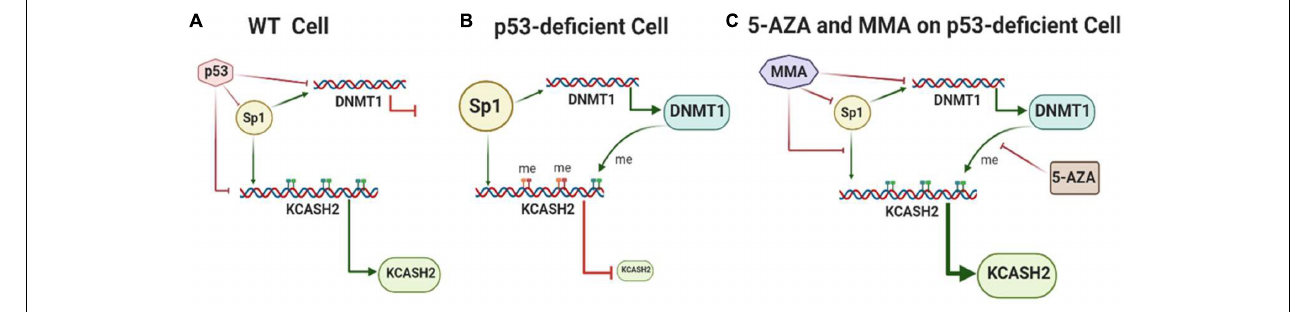
FIGURE 8 | Model of KCASH2 regulation in WT and p53-deficient cells. (A) In WT cells, transcriptional activity of the KCASH2 promoter is balanced by the effect of basal transcription sustained by Sp1 and suppression operated by p53. In this context, p53 also inhibits Sp1-dependent DNMT1 transcription, leaving the KCASH2 promoter accessible to transcription factors. (B) In p53-deficient cell, Sp1 is upregulated and leads to active DNMT1 transcription. The consequent methylation on CpG islands of the KCASH2 promoter inhibits Sp1 binding and its capability to activate KCASH2 transcription, resulting in low levels of KCASH2. (C) MMA and 5-AZA treatment in p53-deficient cells enhance KCASH2 transcription. MMA reduces Sp1 levels, and its binding and activation of the DNMT1 promoter. 5-AZA treatment leads to demethylation of the CpG island rendering KCASH2 promoter available for Sp1 binding and Sp1-mediated basal